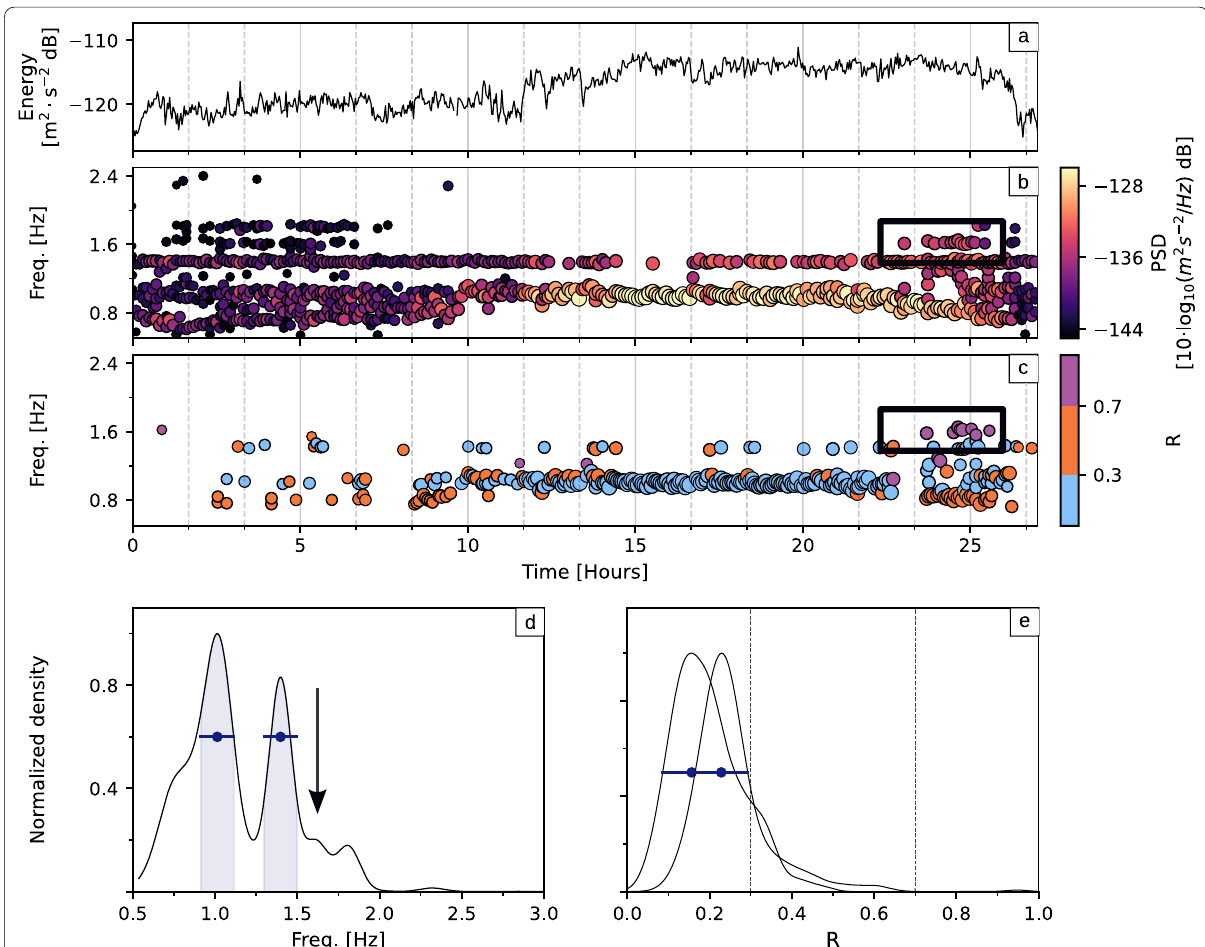
Fig. 5 The NB tremor occurred at 01:20:00 UTC on 01 January 2015. a Energy in the range 0.5–10 Hz. b Spectral peaks with energy above 95% of the maximum. c Averaged rectilinearity (R) of each sample in the range 0.05 Hz when σR ⩽ 0.1. The normalized PDF of averaged horizontal azimuth ± ΘH (cid:31) H ( d ), and vertical incidence ΘV (cid:31) H ( e ) in the range 0.1 ± 0.1 Hz around the characteristic peaks. Black rectangular boxes in b and c show the ± 1.6-Hz secondary peak that is filtered in the statistical analysis in